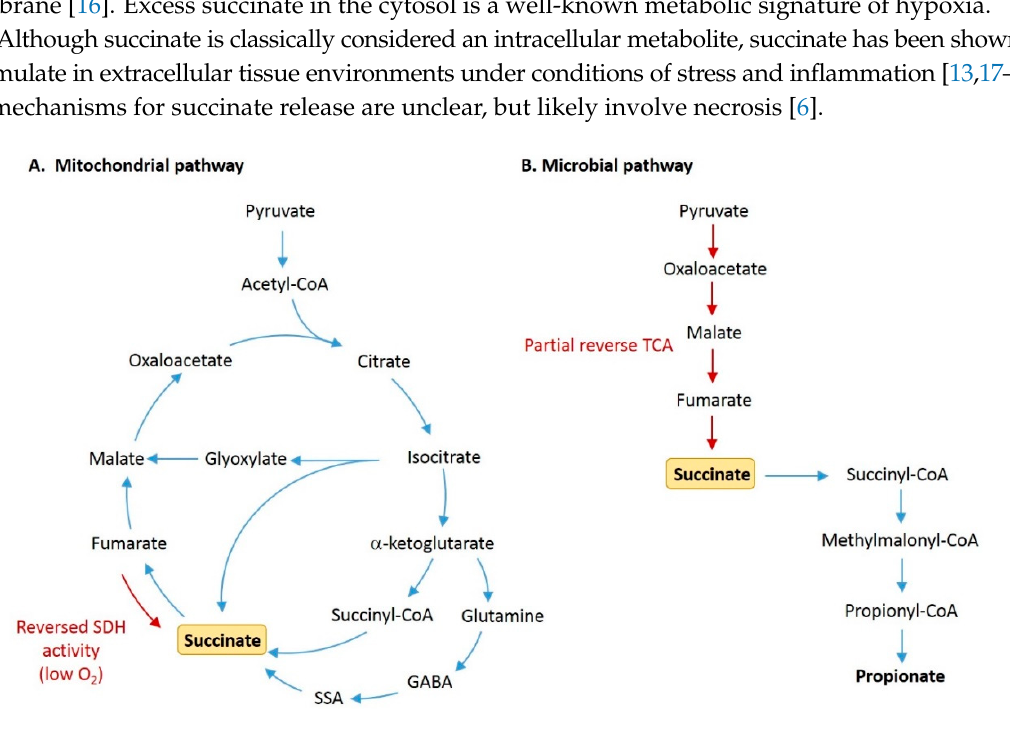
Figure 1. Pathways for production of succinate by host cells and gut microbiota. ( A ) In the regular tricarboxylic acid (TCA) cycle within host mitochondria, succinate is produced as an intermediate metabolite formed from the conversion of succinyl-CoA, and is then oxidized by succinate dehydrogenase (SDH) to form fumarate. Succinate is also produced from succinic semialdehyde (SSA) via the γ -aminobutyric acid (GABA) shunt, and from isocitrate via the glyoxylate shunt. Under conditions of low oxygen, succinate can accumulate due to reversed action of SDH. ( B ) In microbial fermentation, succinate is commonly formed by the reversal of partial TCA cycle reactions. Pyruvate is carboxylated to form oxaloacetate, which is then reduced to malate, fumarate, and succinate. Succinate can then be decarboxylated to form propionate.